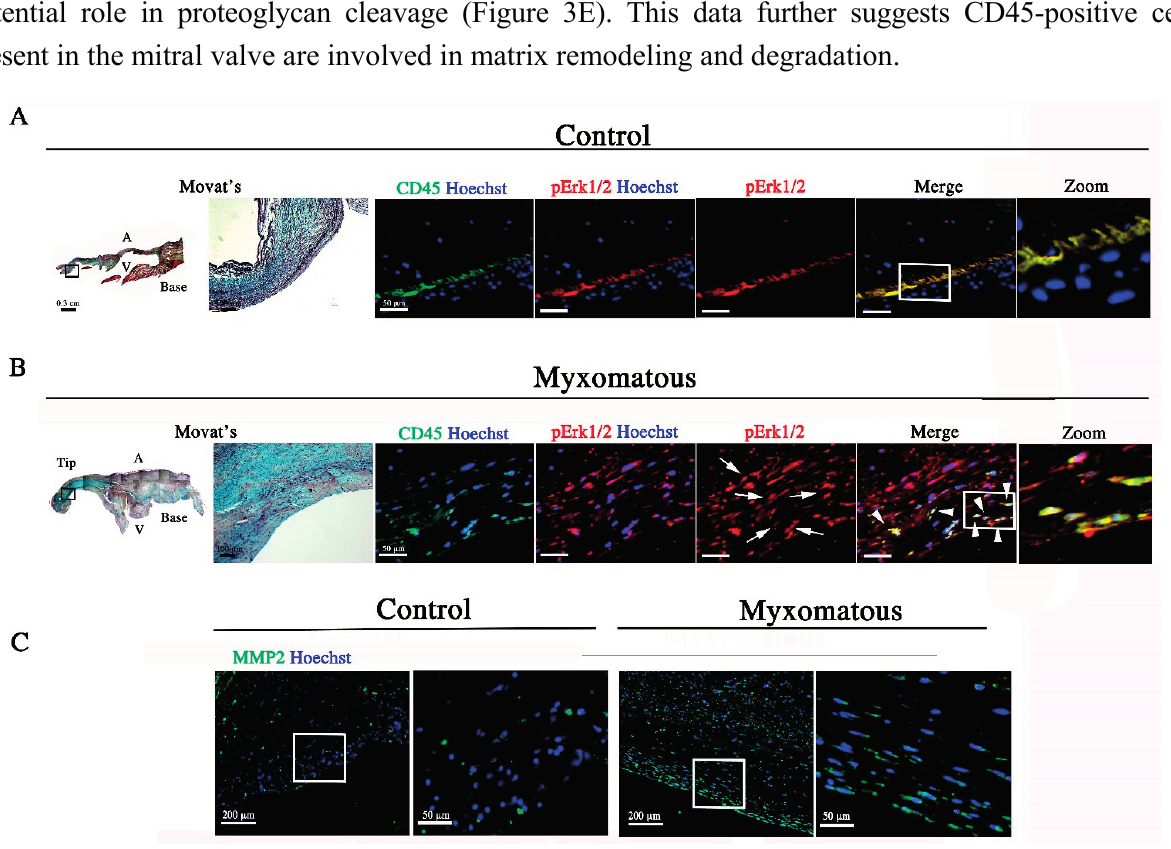
Figure 4. Myxomatous Human Mitral Leaflets Show Increased Infiltration of CD45-positive Cells. ( A ) IHC for CD45 ( green ) and pErk1/2 ( red ) and Movat’s depicting elastin/nuclei ( black ), collagen ( yellow ), proteoglycans ( blue ), in the posterior leaflet from a normal human mitral valve; ( B ) Movat’s and IHC in a myxomatous mitral leaflet form a human patient shows increased pErk1/2 ( red ) and CD45 cell ( green ) infiltration compared to control. CD45-positive cells also express pErk1/2 ( arrowheads ) and pErk1/2 is nuclear ( arrows ); ( C ) IHC for MMP2 ( green ) shows increased expression in the human myxomatous posterior leaflet. All images depict similar anatomical regions of the posterior